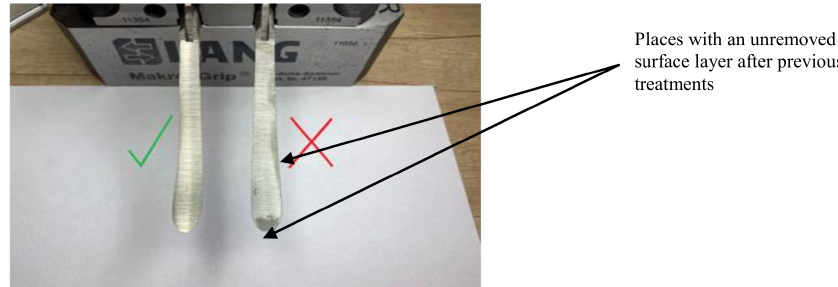
Figure 5. Surface cleanliness assessment.